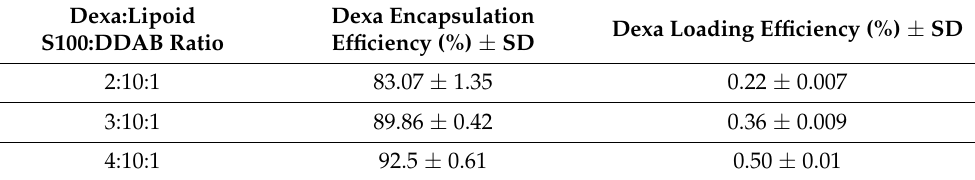
Table 1. Values of Dexa Encapsulation efficiency (%) and Dexa Loading efficiency for different ratios of Dexa:Lipoid S100:DDAB used in Lmp/Dexa